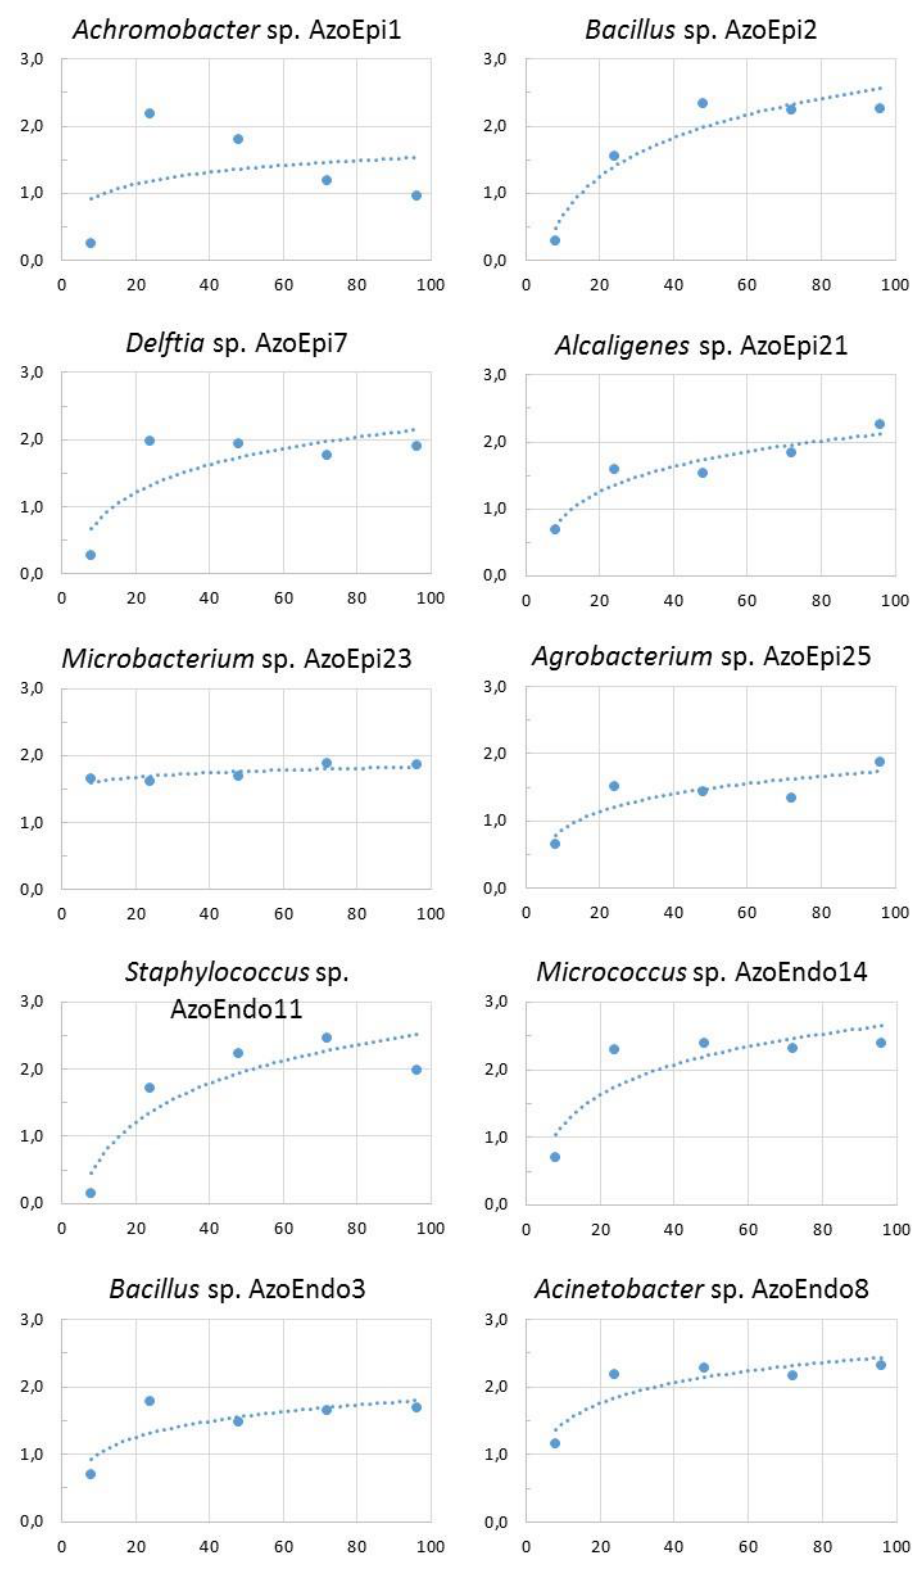
Figure A1. Growth curves for the cultured microorganisms selected for phenotyping. X -axis presents time of incubation (hours) and Y -axis values of OD 600 . Logarithmic curves are fitted to the